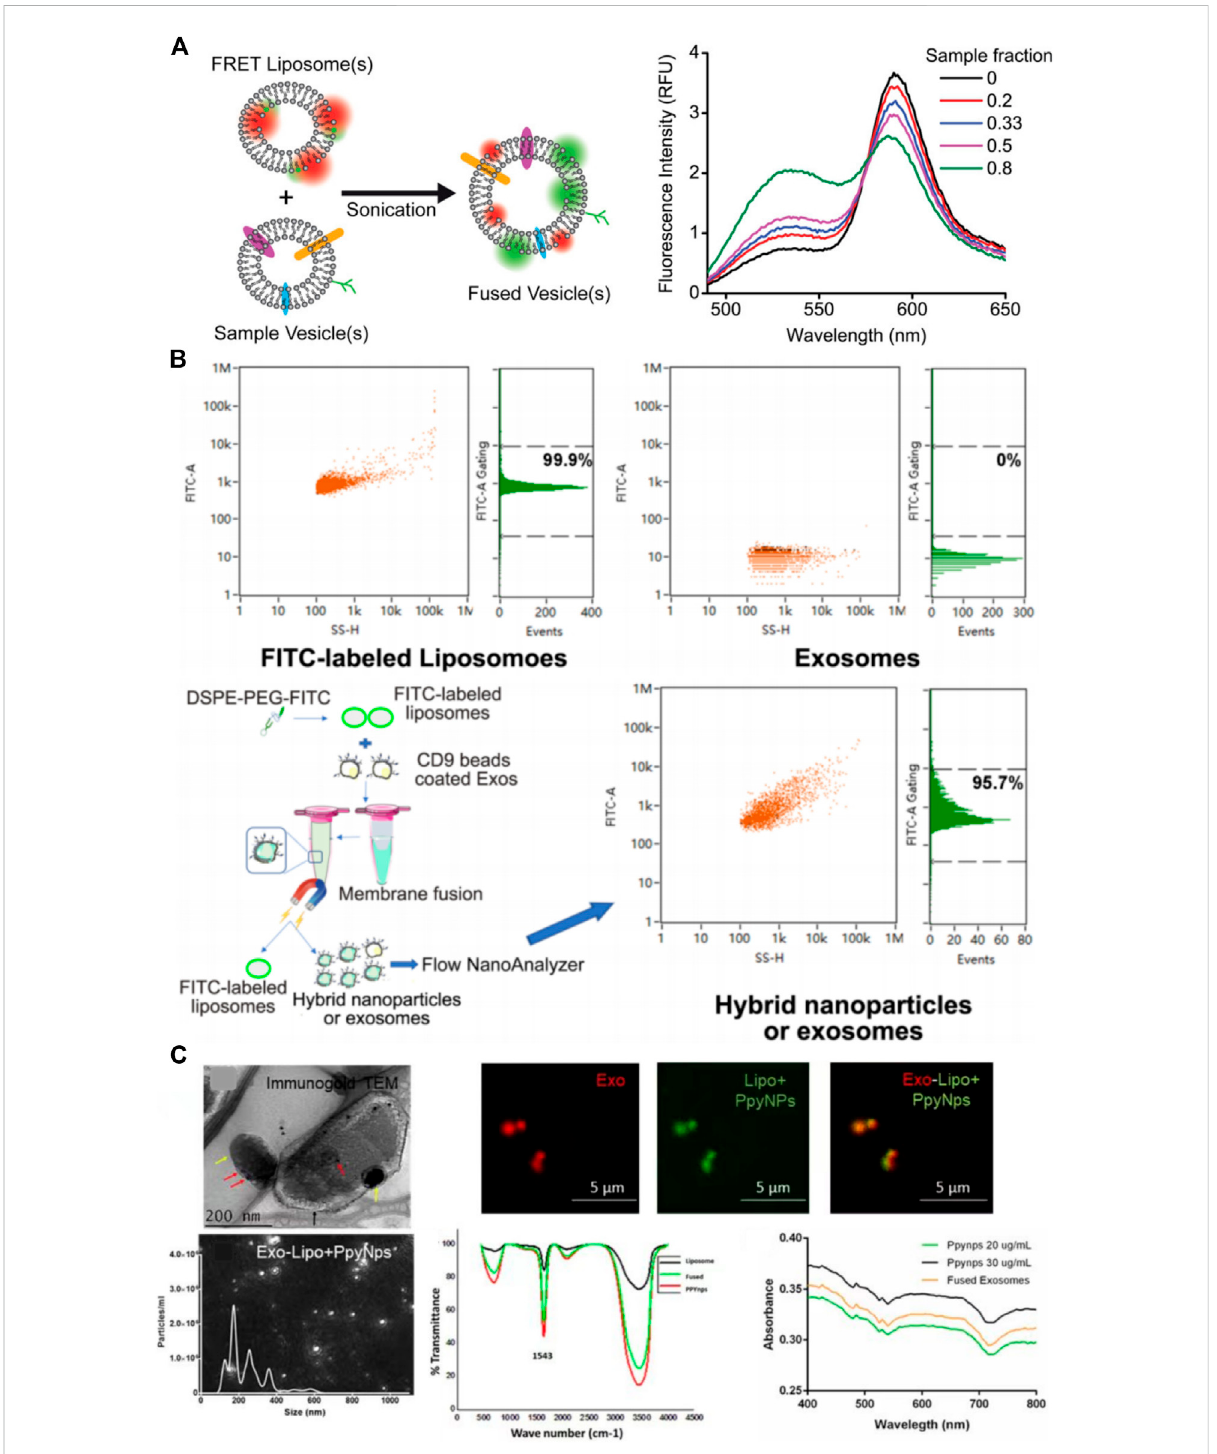
FIGURE 2 Characterization ofmembranefusion-based hybrid exosomes. (A) FRET assay to characterizemembrane fusion(Thorsteinsson etal., 2020) (B) Immunomagnetic bead method to characterize membrane fusion (Lv et al., 2020) (C) TEM & confocal fl uorescence microscopy analysis to visualize membrane fusion (Singh et al.,